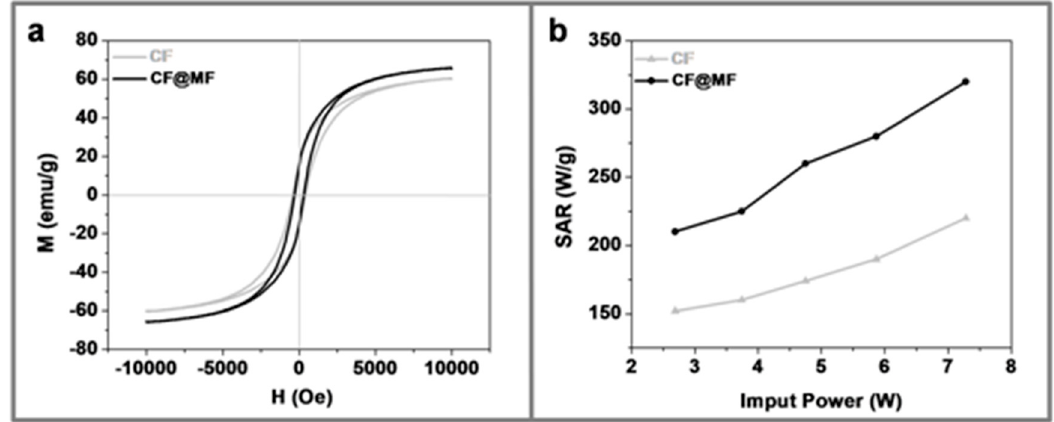
Figure 4. ( a ) Magnetization curves of CF (grey) and CF@MF (black) nanoparticles. ( b ) SAR for different power values of the CF (grey) and CF@MF (black) nanoparticles (at a frequency of 1950 kHz).